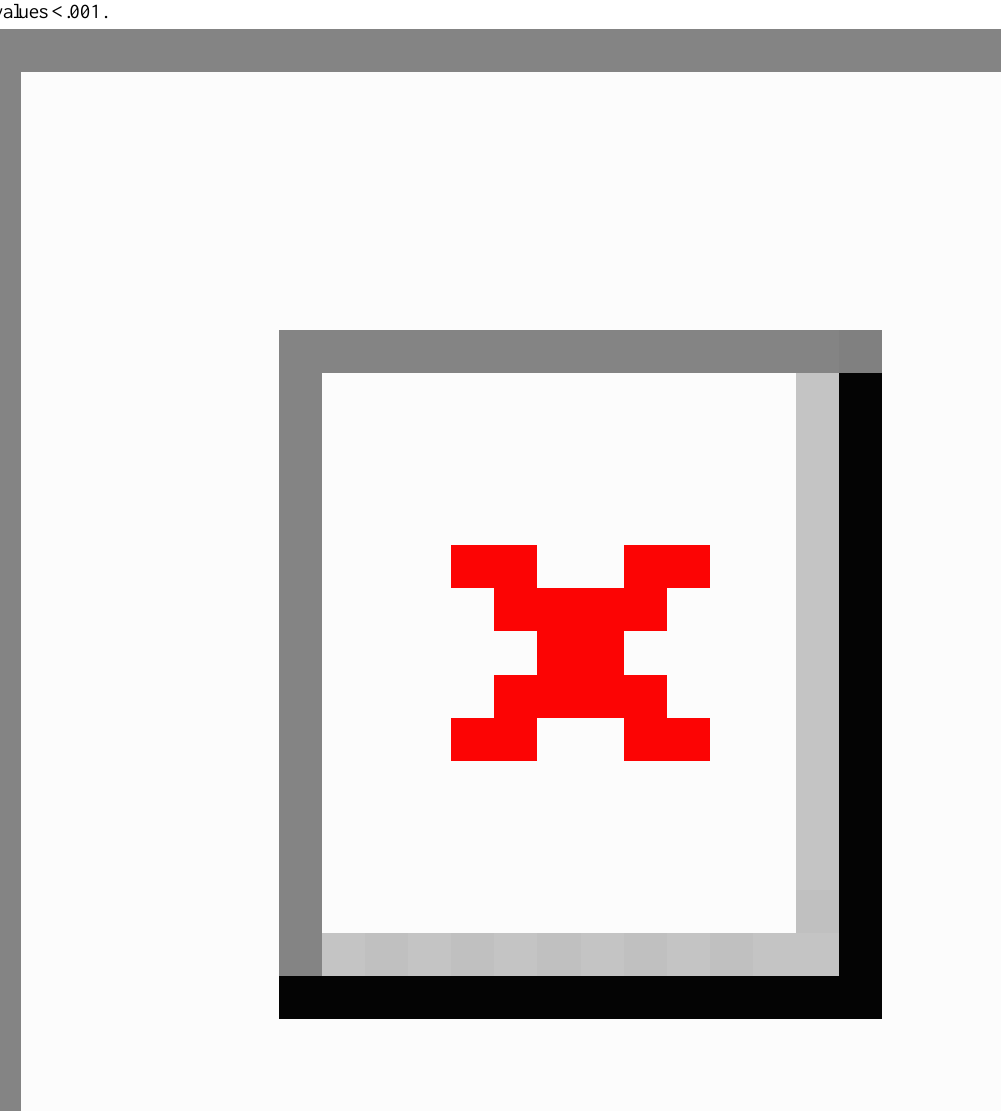
Figure 4. Path model showing the analysis of the social support communication process based on machine-coded data. ε 1 and ε 2 indicate error terms. All P values